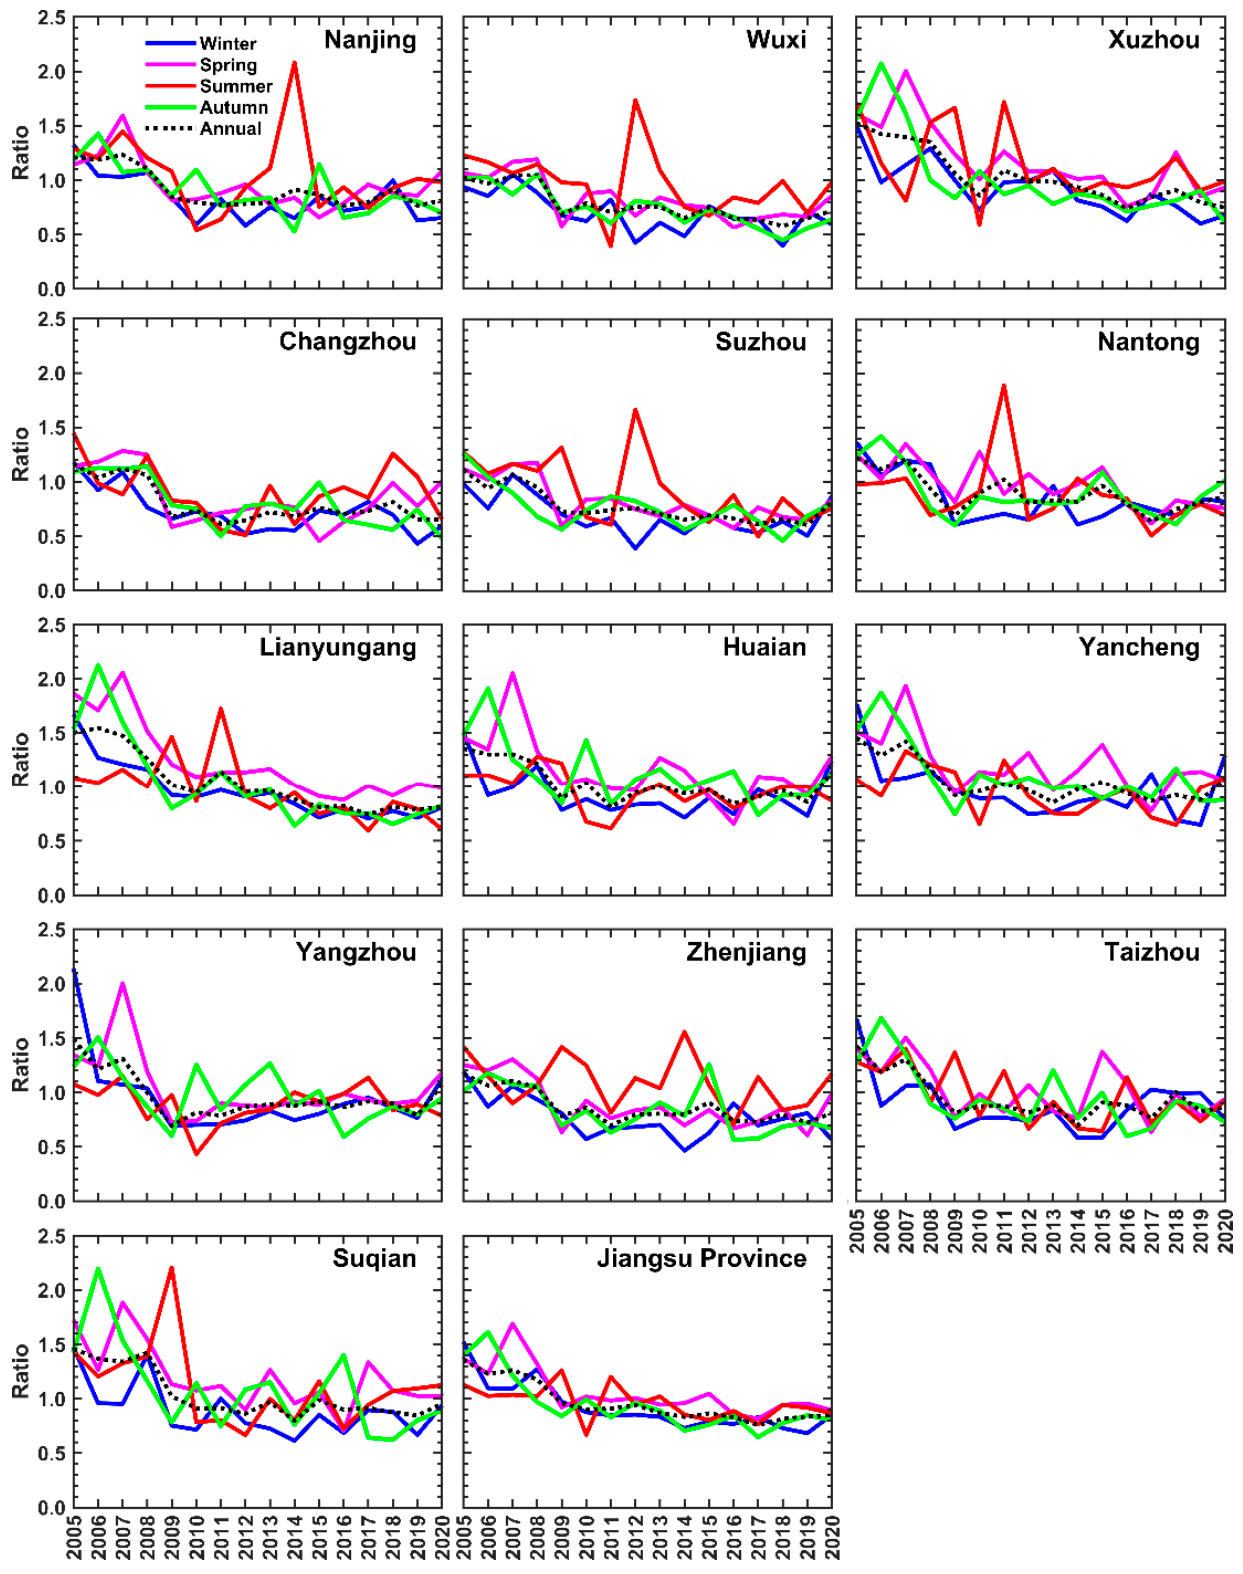
Figure 5. Annual and seasonal variations in the SO 2 /NO 2 ratio, obtained from OMI, in 13 cities of Jiangsu Province from 2005 to 2020.